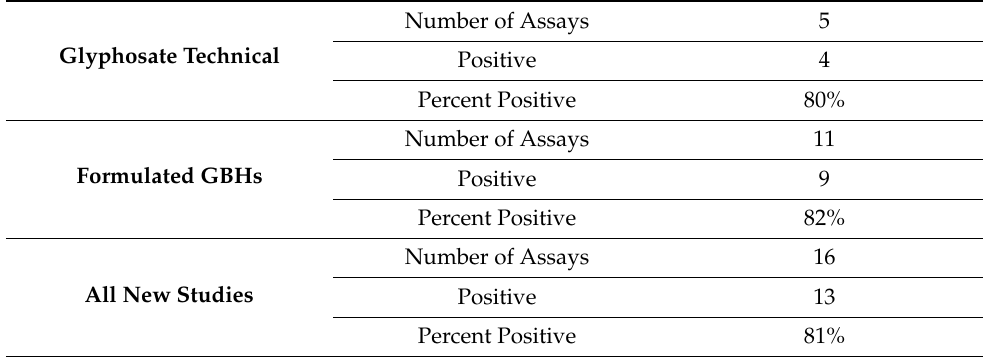
Table 1. Mammalian In Vivo Genotoxicity Assays Published Since the EPA and IARC Reviews of Glyphosate and GBH